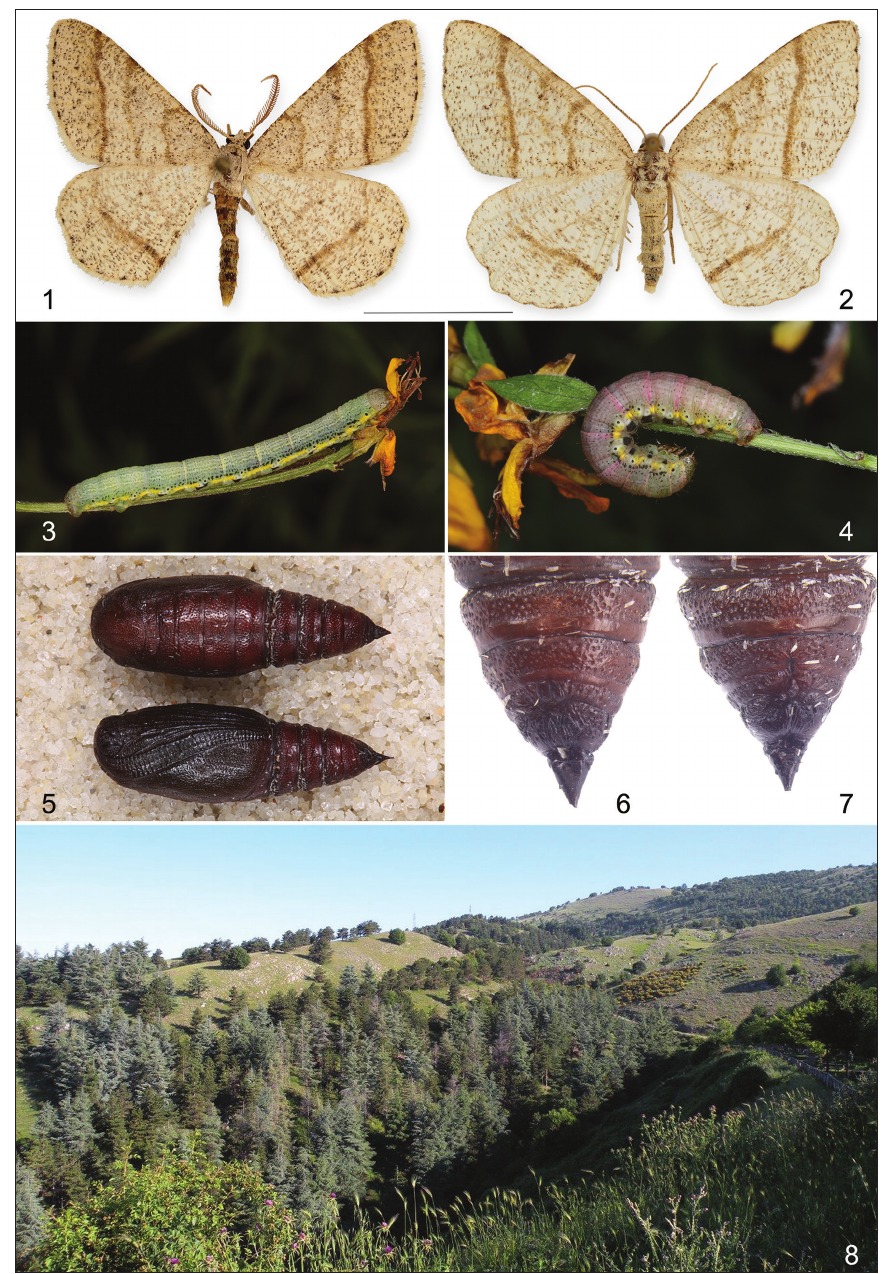
leg . Teobaldelli, in coll. M. Leipnitz). 2. Female (Italy, Abruzzo, Majella, 450 m, Fara S. Martino, Valle del Fossato, 26.vi.2009, leg . N. Zahm, in coll. M. Leipnitz). 3. Fifth instar larva (L5). 4. Pre-pupal stage. 5. Pupa. 6–7. Pupal cremaster of male ( 6 ) and female ( 7 ). 8. Habitat of Isturgia sparsaria , where female specimen was collected: Acuto (Italy, Prov. Frosinone, altitude 770 m). Scale-bar for Figs 1, 2: 1